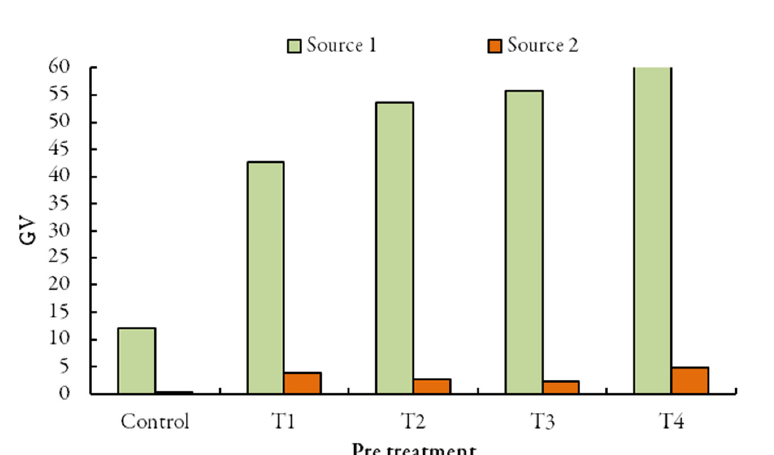
Figure 2. Germination value (GV) of Pyrus pashia seeds from Source 1 (Champawat) and Source 2 (Pithoragarh) in pre-soaked seeds in T1-100 ppm, T2-300 ppm, T3-500 ppm and T4-700 ppm GA 3 solution